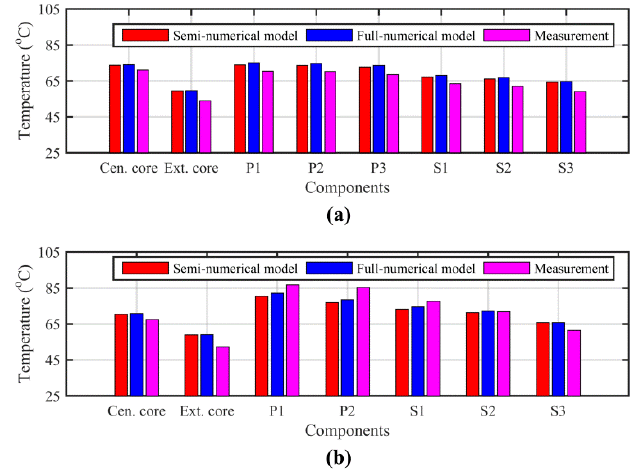
Figure 7. Temperature distribution in transformer active components and oil for the two investigated prototypes.